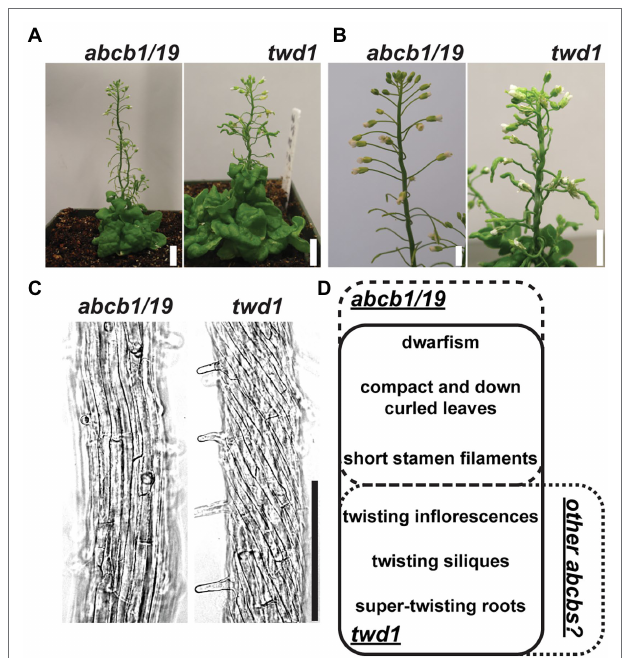
FIGURE 1 | twd1 exhibits additional root, shoot, and silique twisting not observed in abcb1/19 . (A) Comparison of mature plant phenotypes of abcb1/19 and twd1 . (B) Close-up of twisting inflorescence stems and siliques observed in twd1 but not in abcb1/19 . (C) Bright field images abcb1/19 and twd1 roots. Images were converted to black and white, and brightness and contrast were adjusted to show cell files. (D) Venn diagram of the major phenotypes of abcb1/19 and twd1 , and twd1 phenotypes that may be accounted for in other abcb mutants. Scale bars: (A) 1 cm; (B) 500 μ m; (C) 200 μ